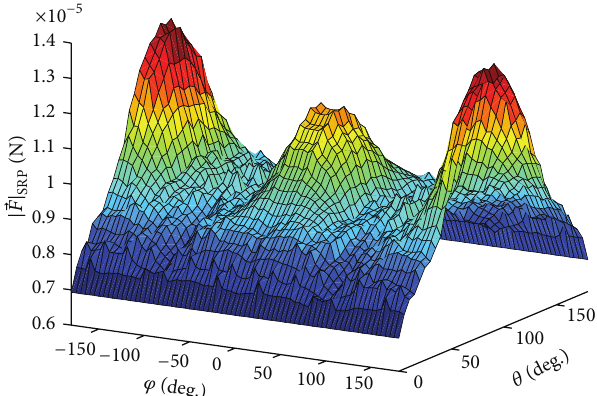
1.751.801.851.901.952.002.052.102.15 Figure 7: Investigation of convergence for the projected area of the FE model. The arithmetic mean of the projected area is represented by the dashed gray line. Additionally, the appropriate numbers of computational steps are shown. The black asterisk (together with the light gray dashed line) marks the model of